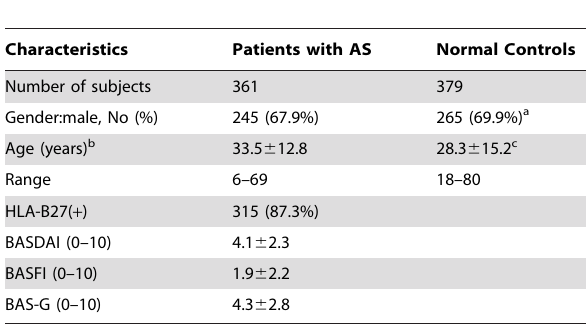
Table 1. Basal characteristics and clinical features of patients with ankylosing spondylitis (AS) and of normal controls.